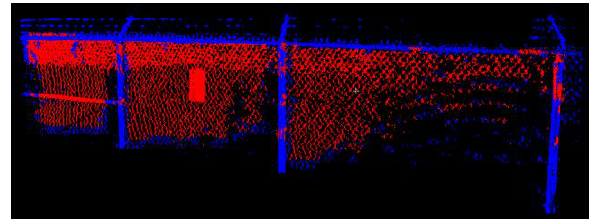
Figure 12. The results of the proposed method on fence